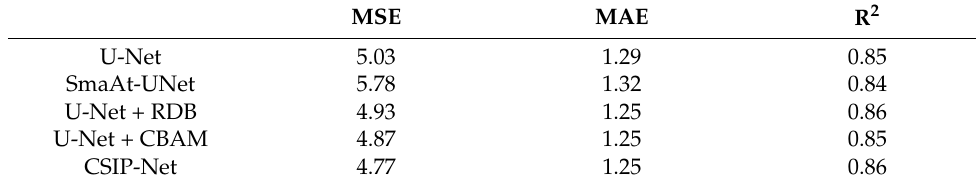
Table 3. The average of the quantitative evaluation results of the four deep learning models.